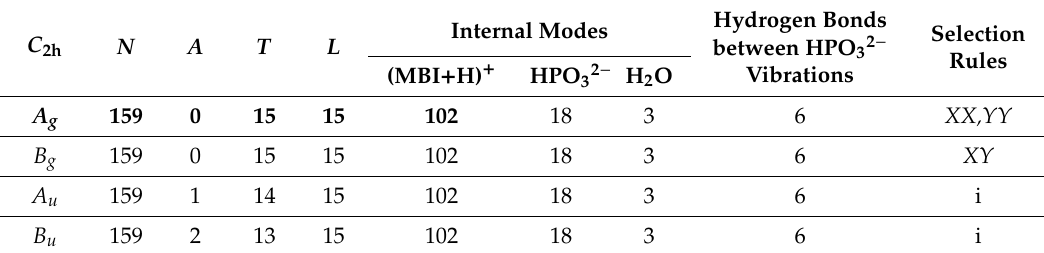
Table 4. Results of the factor group analysis for the MBI-phosphite crystal vibrations and selection rules for Ag and Bg Raman active modes. Space group P2 1 / c (Z = 4). Abbreviations: N = total number of modes, A = acoustic, T = translational, L = librational, i = inactive. Selection rules are given for backscattering geometries -Z(XX)Z, -Z(YY)Z,